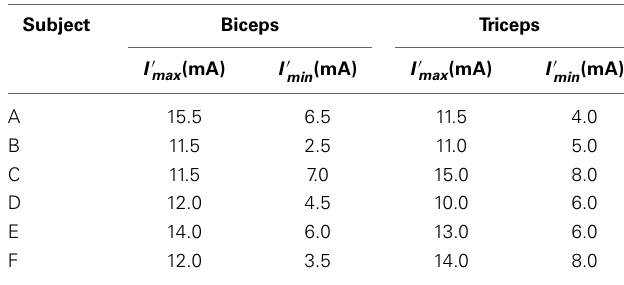
Table 1 | Maximum and minimum stimulation amplitude for the six